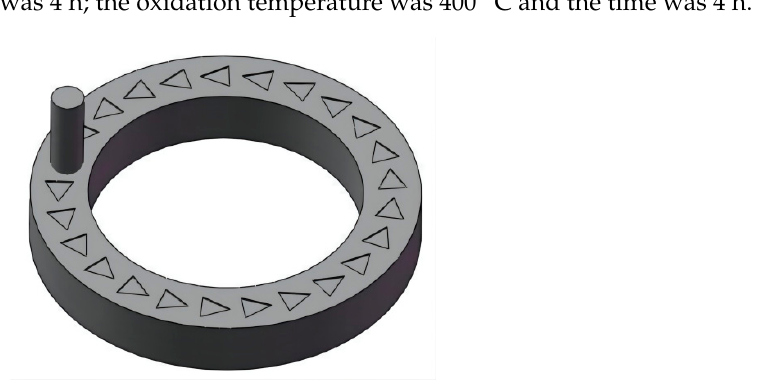
Figure 1. Triangular texture diagram. Table 2. Experimental group